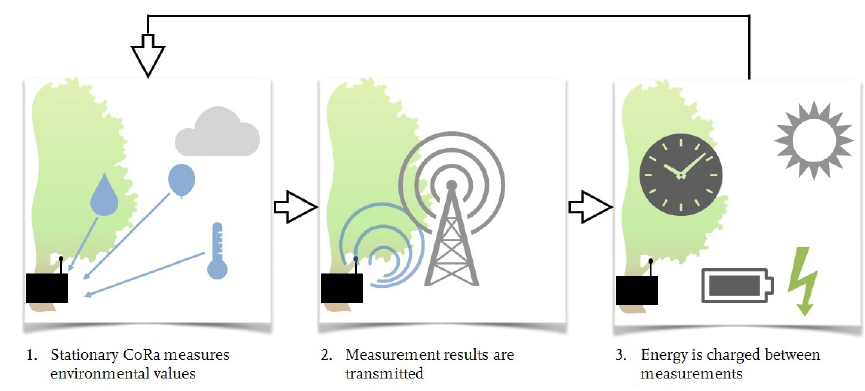
Figure 3. Use case CoRa (constrained LoRaWAN air